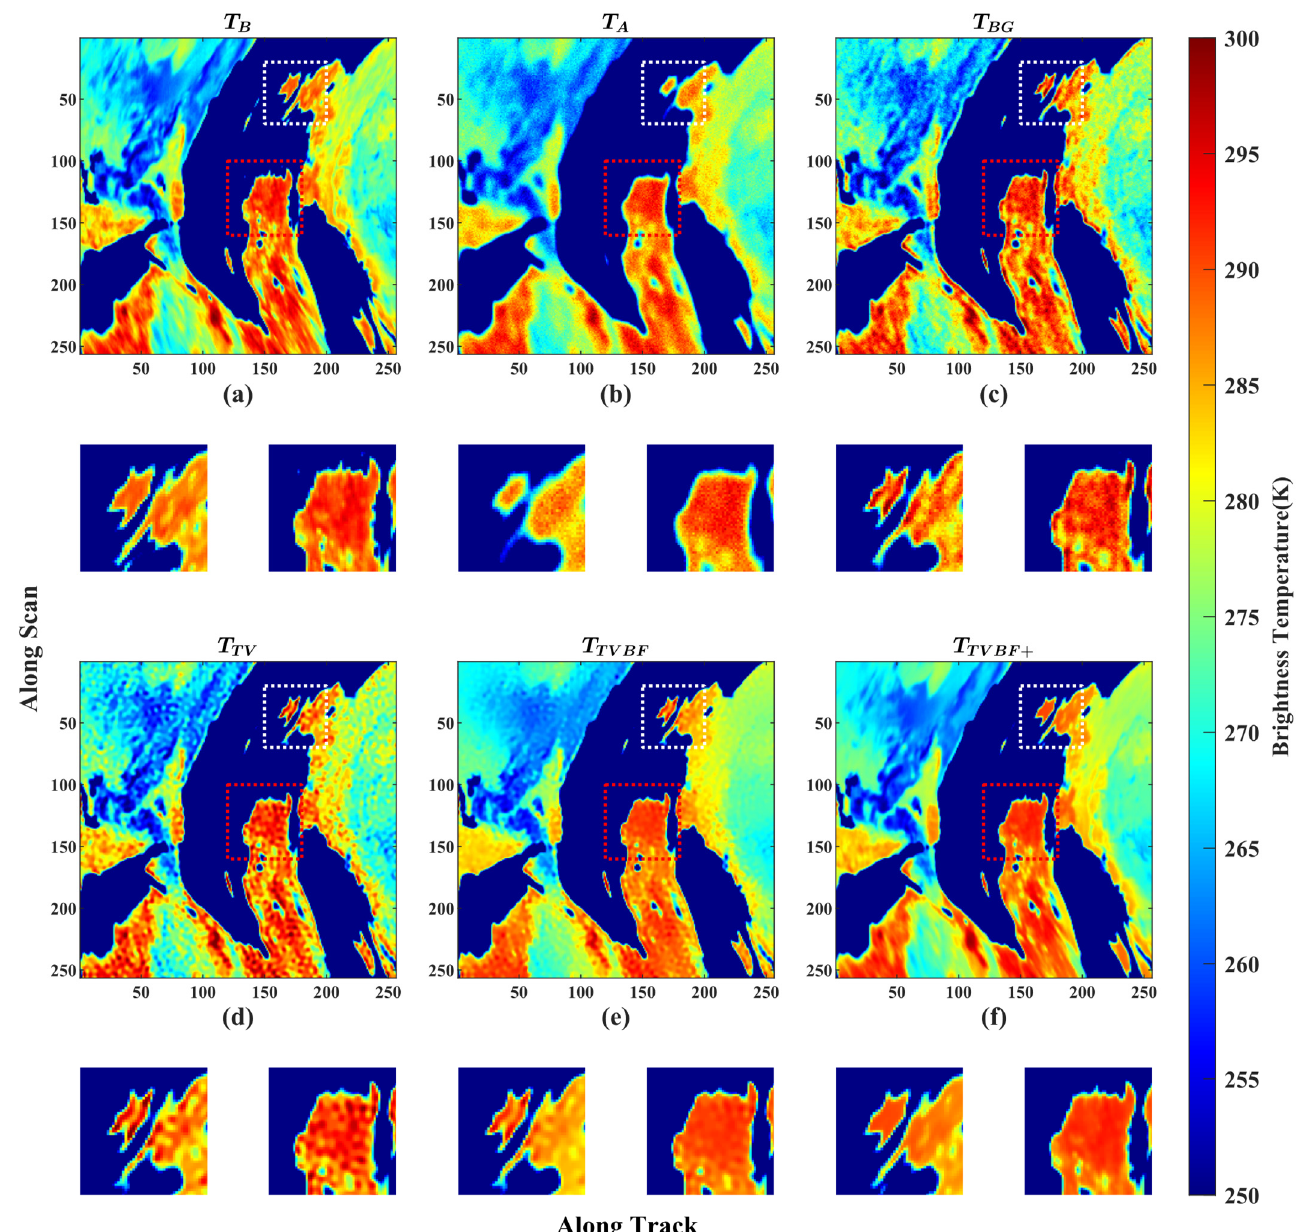
Figure 13. The synthetic MWRI scenario and resolution enhancement results. ( a ) Synthetic 18.7 GHz scene temperature; ( b ) simulated 18.7 GHz antenna temperature; ( c ) the Backus–Gilbert enhancement results; ( d ) the TV enhancement results; ( e ) the TVBF enhancement results; ( f ) the TVBF + enhancement results. (The image in the bottom-left corner is a partial enlargement of the white dotted square and the image in the bottom-right corner is a partial enlargement of the red dotted square).